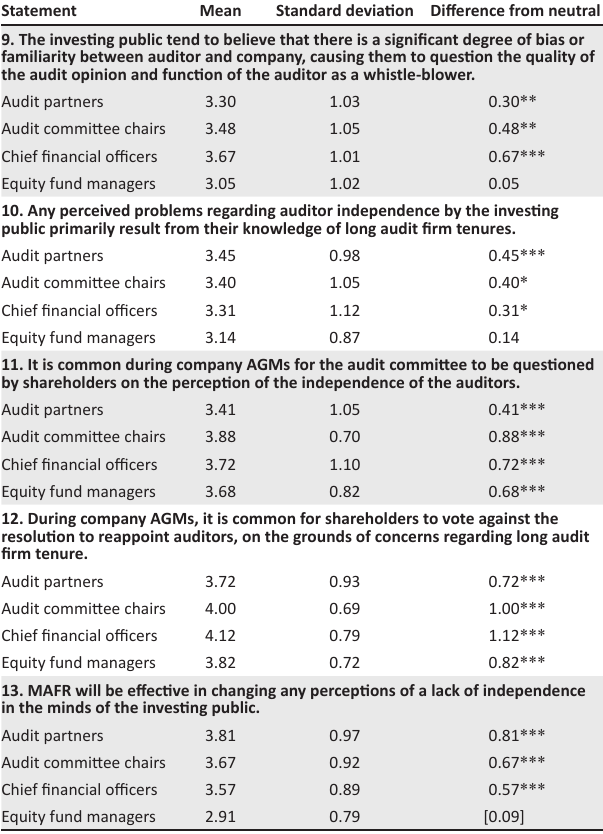
TABLE 4: Perceptions concerning independence and scepticism ‘in appearance’. Statement Mean Standard deviation Difference from